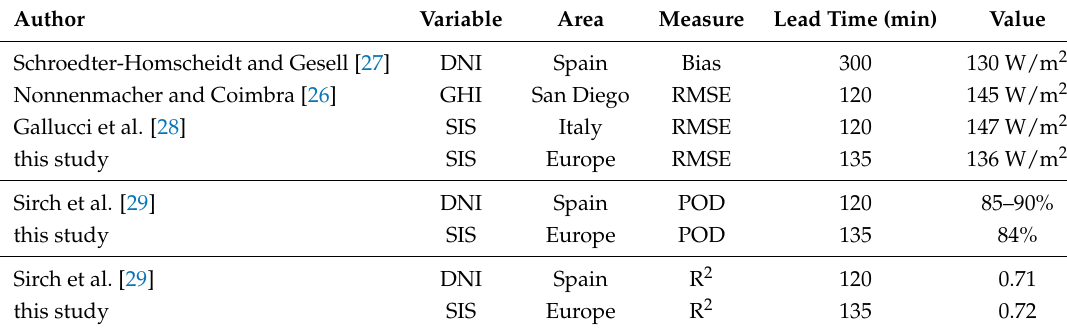
Table 2. List of comparable results (Direct Normal Irradiance (DNI), Global Horizontal Irradiance (GHI), Surface Incoming Shortwave Radiation (SIS)) with different error measures (Root Mean Square Error (RMSE), Probability of Detection (POD)) from other publications and this